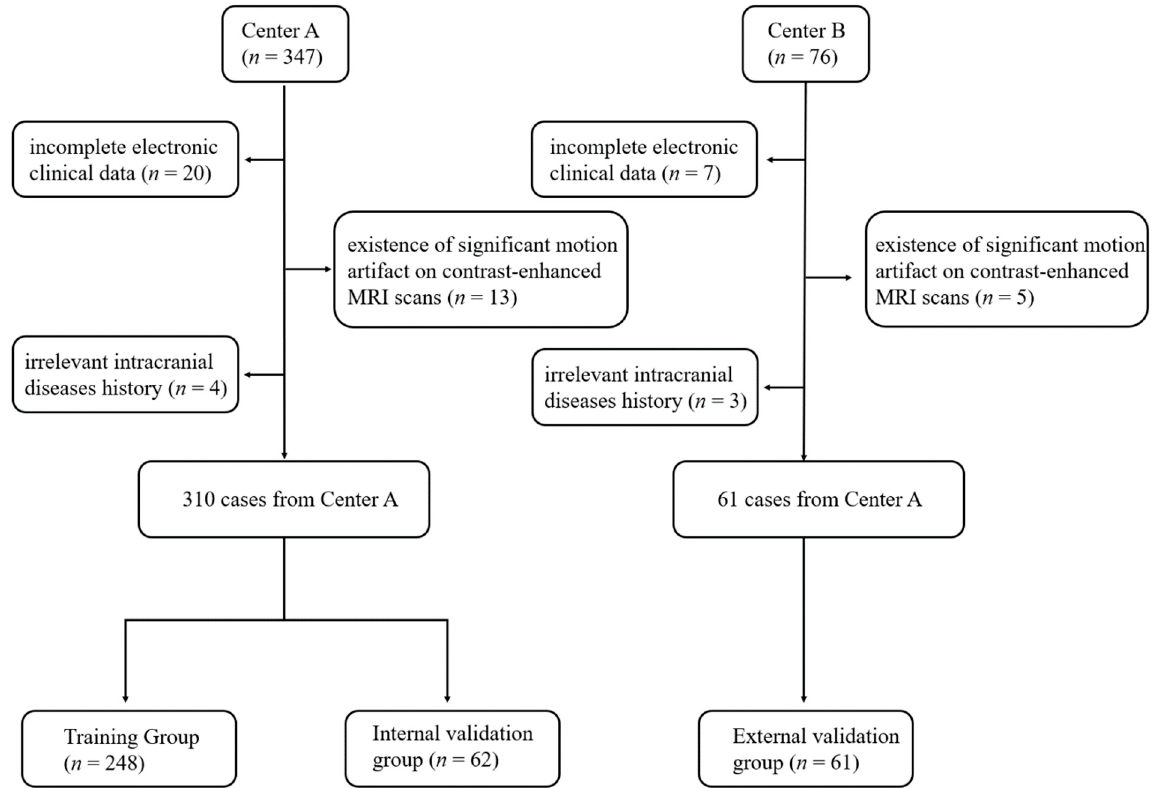
Figure 1. The flowchart of patient selection.